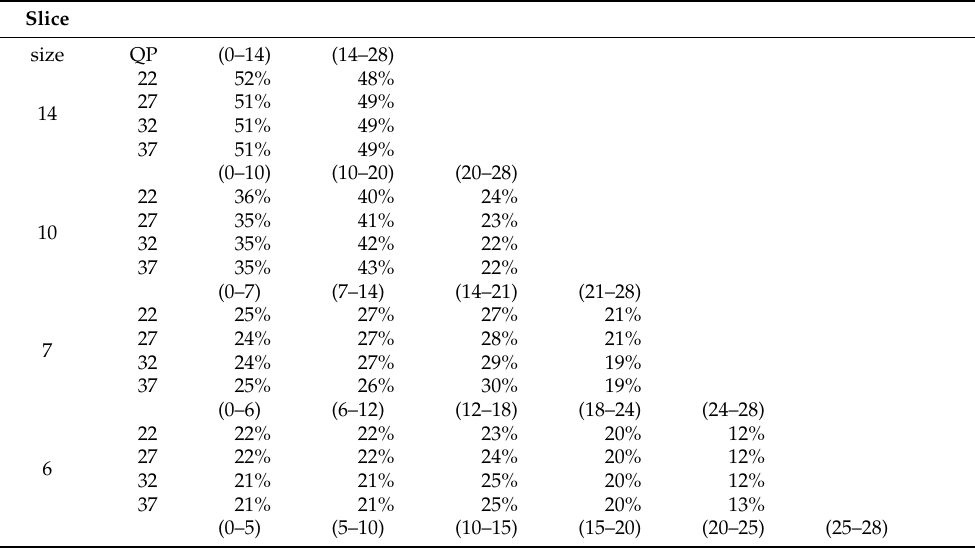
Table 9. Computational cost per slice for Party Scene video